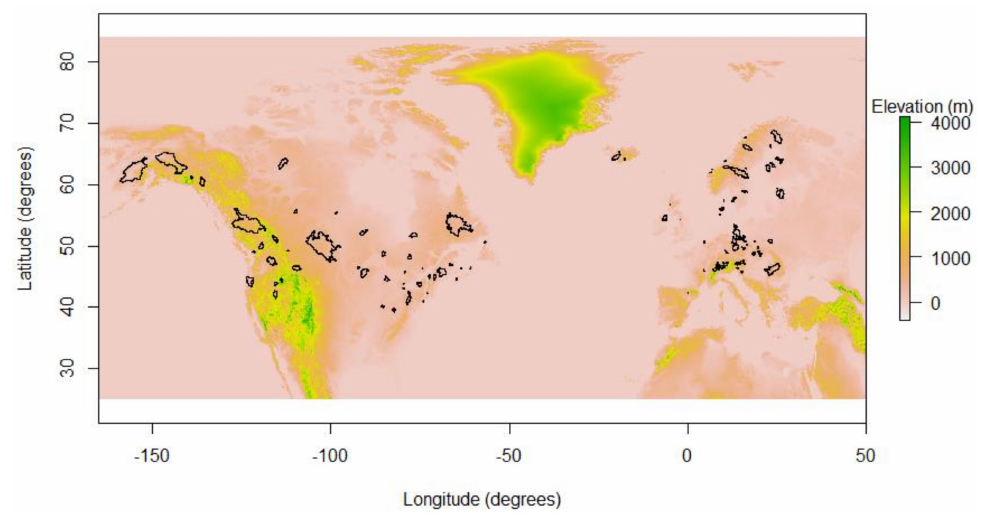
Figure 4. The elevation (m.a.s.l.) data with catchment boundaries (black polygons).